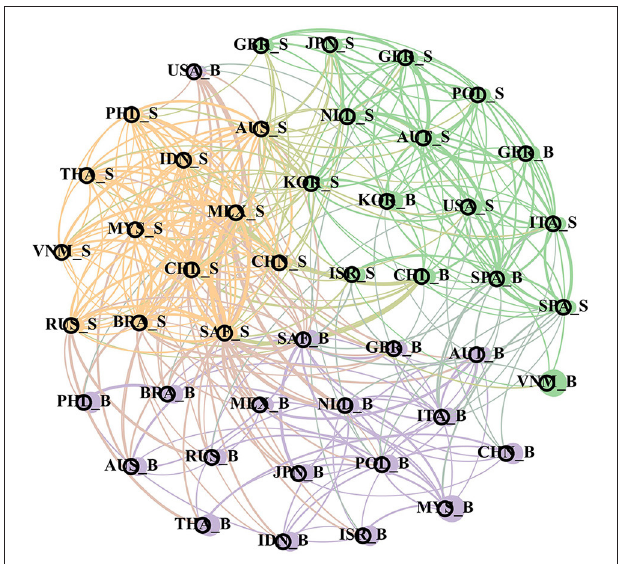
FIGURE 4 | Bank-sovereign risk network in